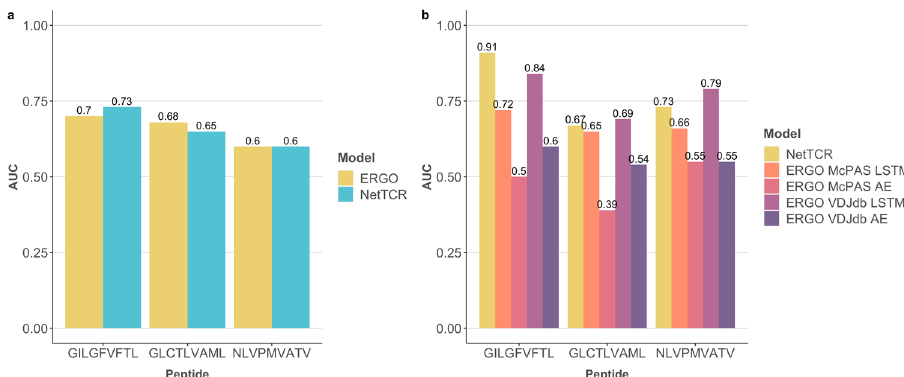
Fig. 2 Comparison between NetTCR and ERGO. a Test AUCs per peptide for NetTCR and ERGO trained on four out of fi ve partitions of the IEDB + 10X data set and evaluated on the left-out partition. b Peptide-speci fi c AUCs for NetTCR and all the four variants of ERGO evaluated on the MIRA